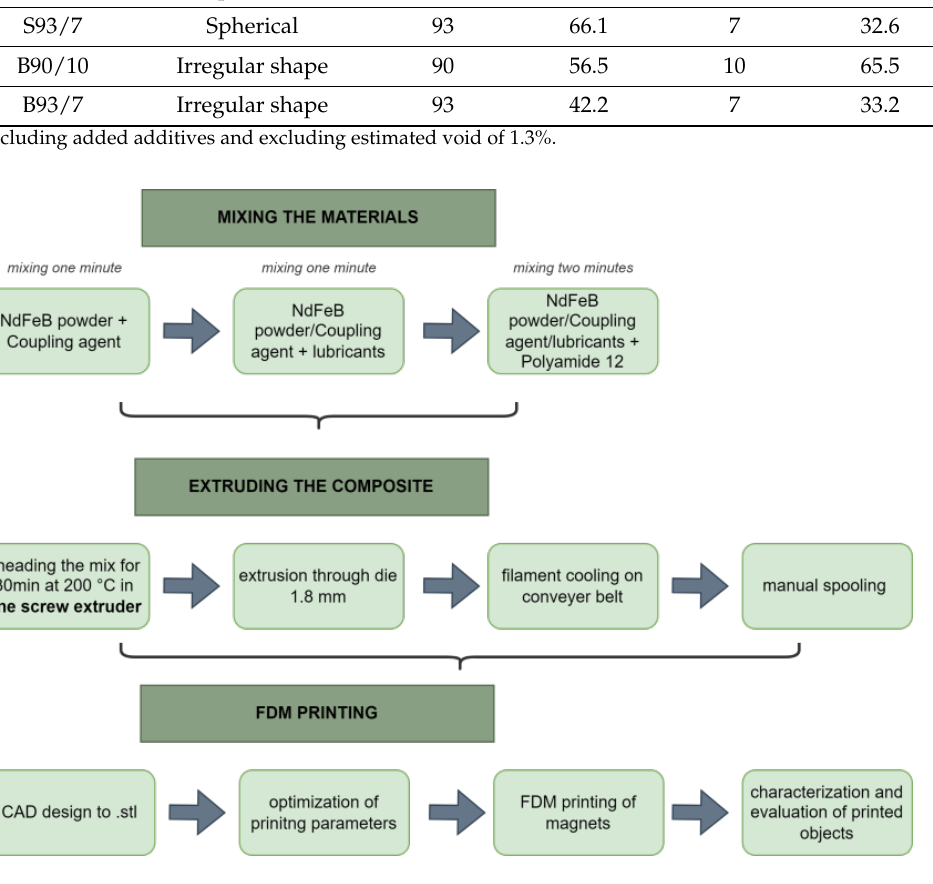
Figure 1. Schematic representation of the production processes for filaments and FDM printing.